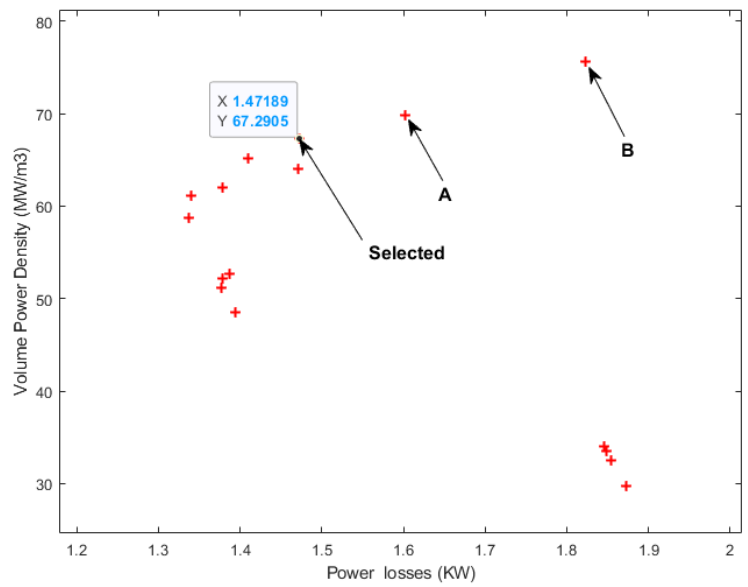
Figure 2. Preliminary sensitivity analysis.